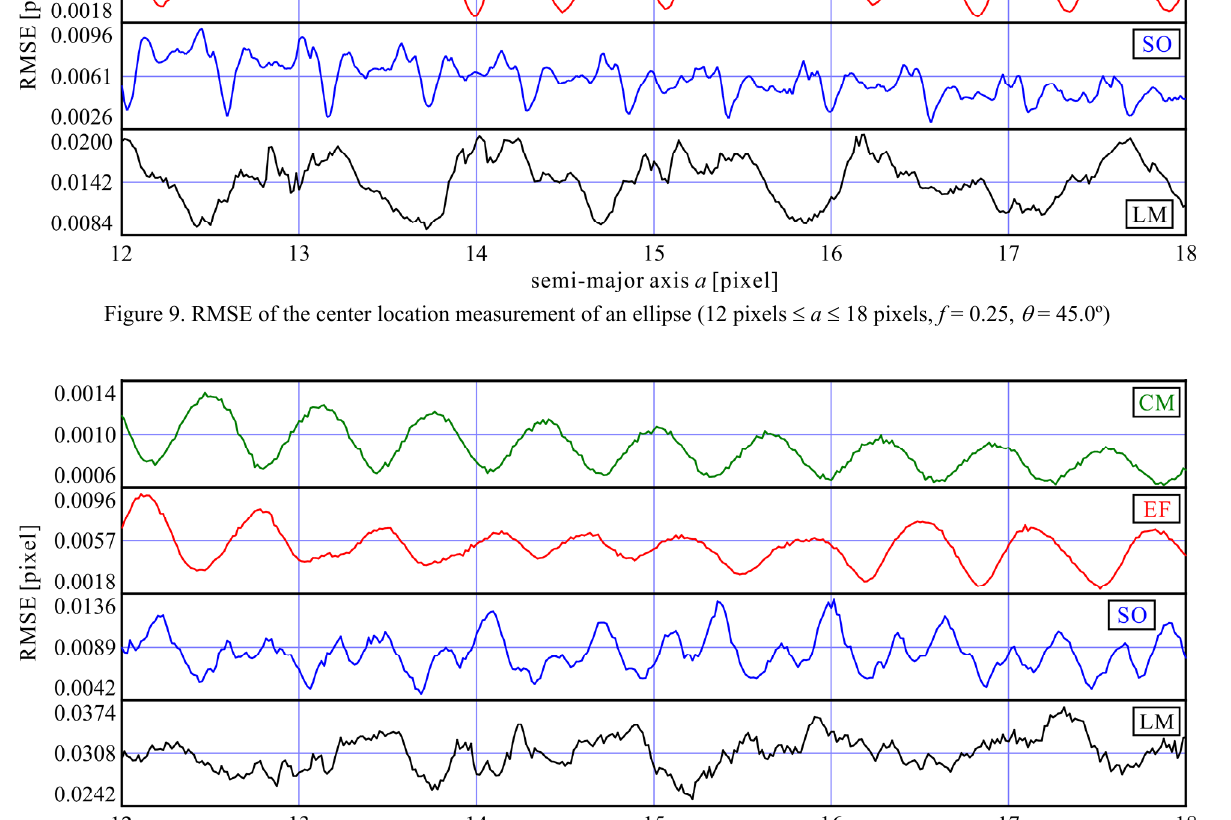
0.0º and  = 22.5º. The cycles of the oscillation shown in Figure 9 and Figure 10 are different as well. Figure 9 indicates that the measurement accuracy by CM has 11 local maxima and 10 local minima in the range {12 pixels  a  18 pixels}, while Figure 10 indicates that the measurement accuracy by CM and EF has 9 local maxima and 10 local minima in the same range. The cycle of the oscillation increases as f increases. The intervals between the adjacent local maxima were not uniform in Figure 9 and Figure 10. The average cycle of the measurement accuracy by CM and EF may be approximately 0.56 pixel in semi-major axis a as to f = 0.25, and approximately 0.63 pixel in semi-major axis a as to f = 0.50. We guessed that the measurement accuracy of the center location of an ellipse by CM and EF might oscillate in an approximately 0.5 pixel cycle in   2 2 2 a b  when  = 45.0º.